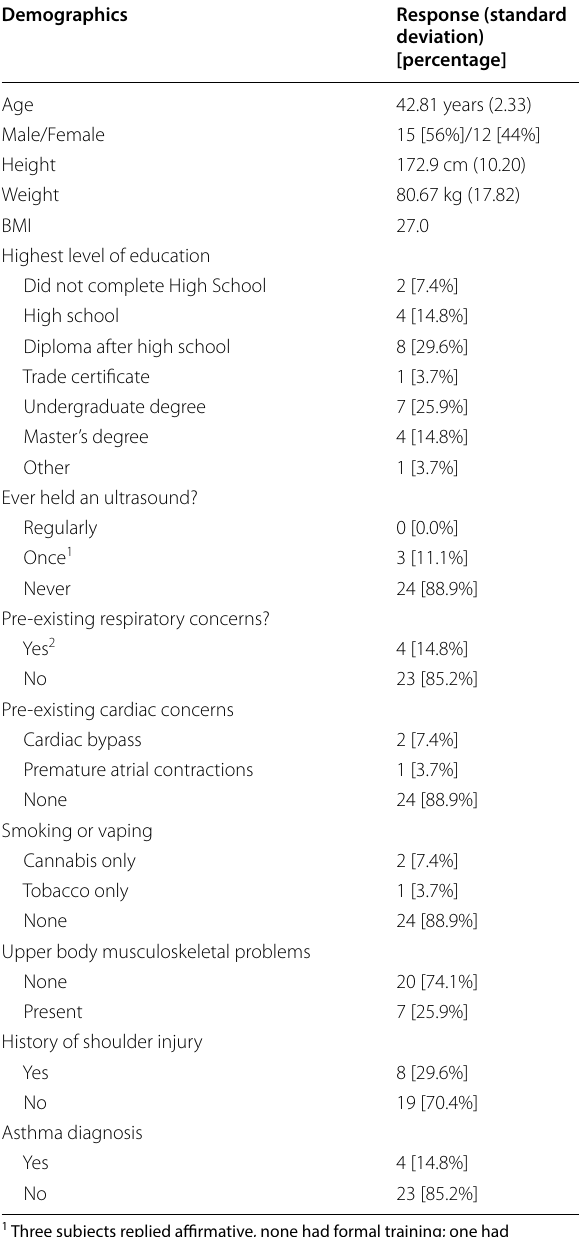
Table 1 Demographic profile of the 27 ultrasound-novice self- isolating